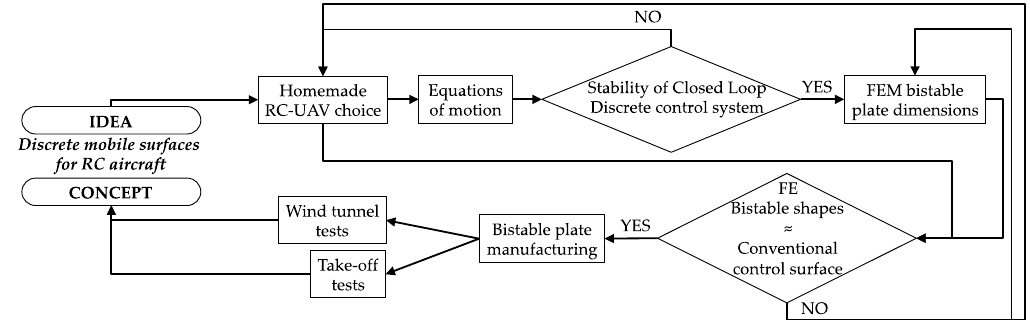
Figure 1. Schematic of the present research.